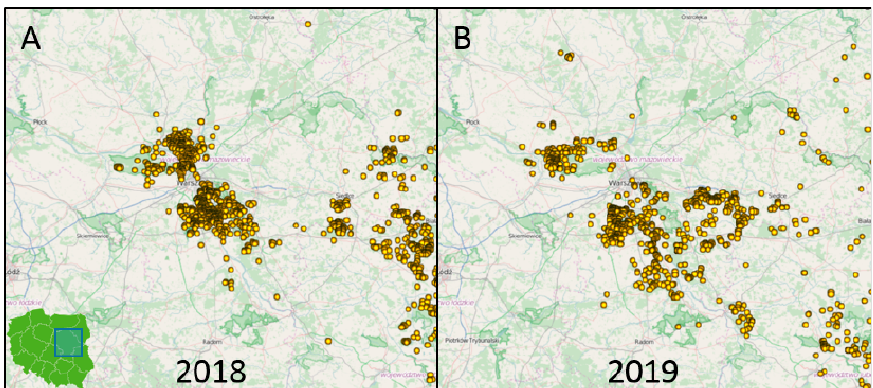
Figure 2. Spatial distribution of ASF cases in wild boars in the Warsaw cluster in: ( A )—2018 and ( B )—2019. Two geographically separated clusters are observed: northwestern and southeastern. The maps were derived from the website of the General Veterinary Inspectorate in Poland [16].